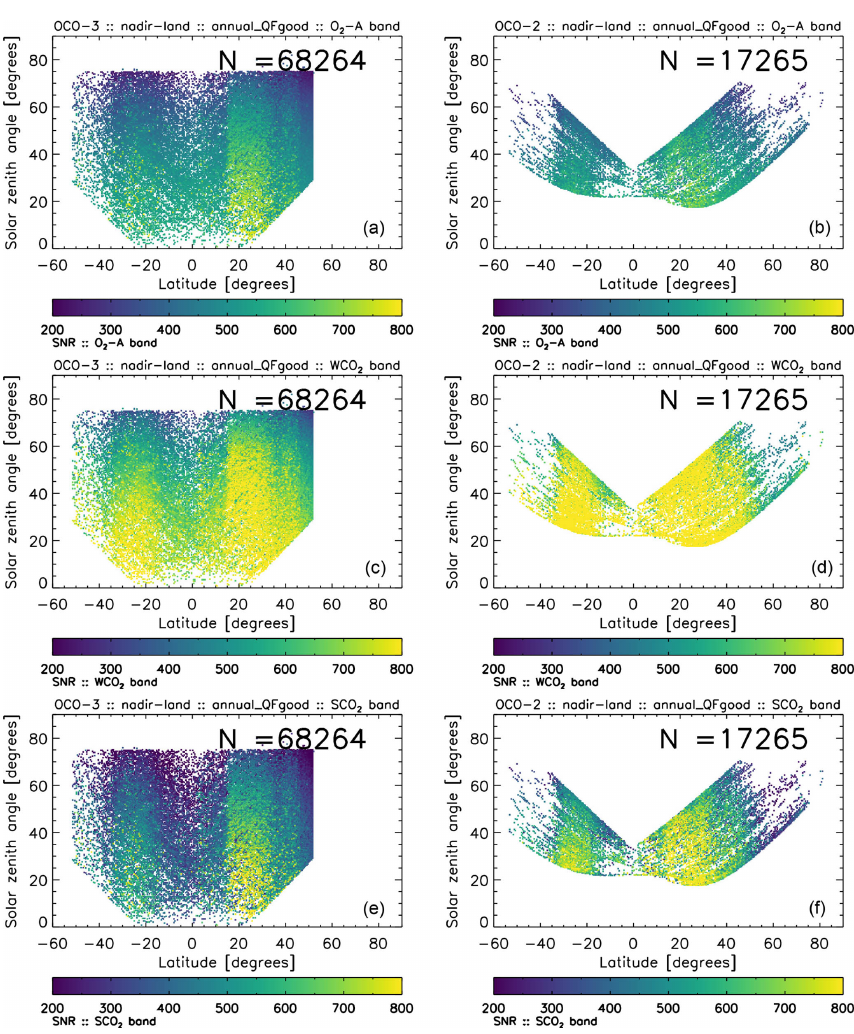
Figure 10. Comparison of the nadir–land SNR of OCO-3 (a, c, e) to OCO-2 (b, d, f) for each spectral band (rows) for the full annual dataset. Both datasets have been filtered using the L2FP quality flag. The operational OCO-2 data have been down-selected to include a single footprint and one sounding every 10s to provide a fairer comparison against the OCO-3